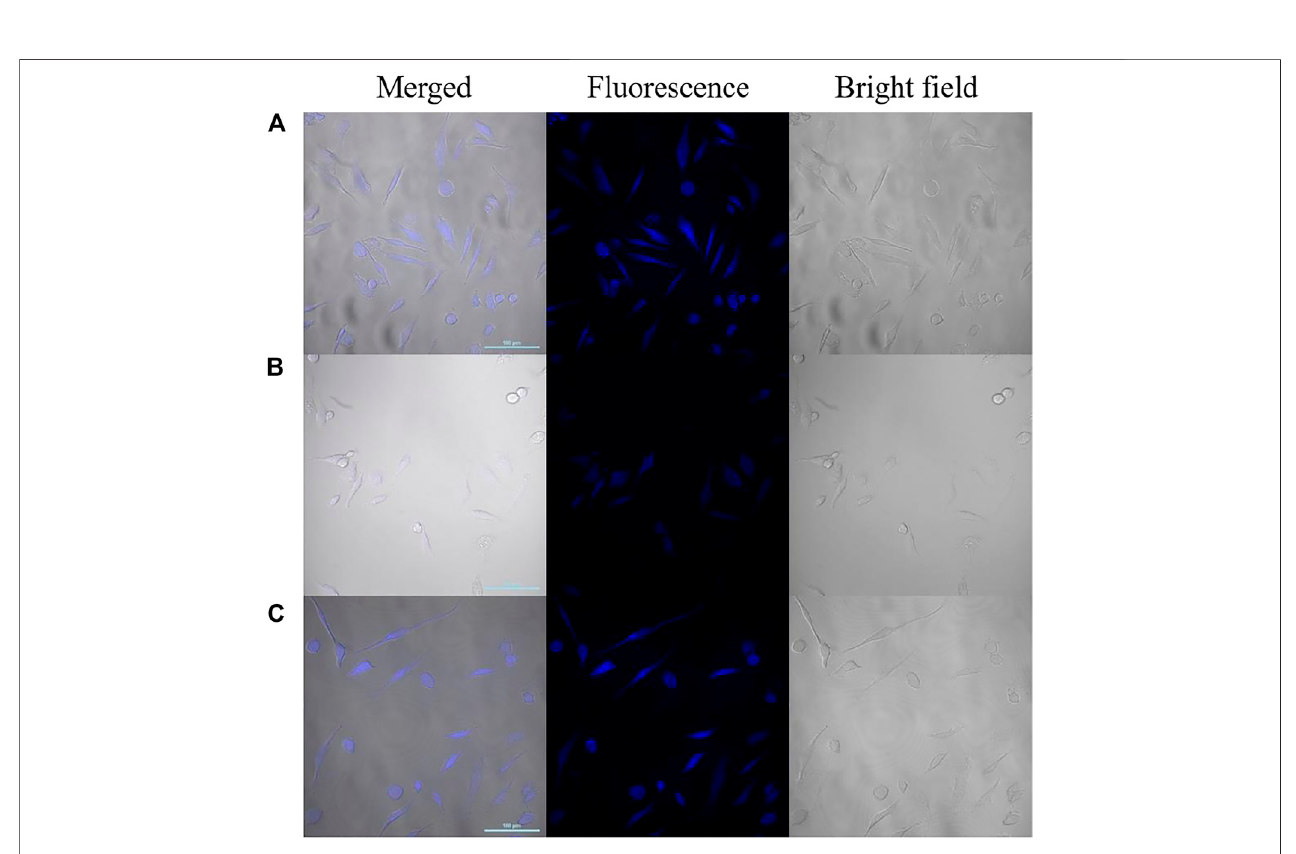
FIGURE8| Confocallaser fl uorescenceimagesofHeLacellsincubatedwithCDs (A) ,CDs/NO 2- (B) andCDs/NO 2- /SO 32- (C) (Left:themergedimage;middle:the fl uorescence image; right: the bright fi eld image; scale bar: 100 μ m).